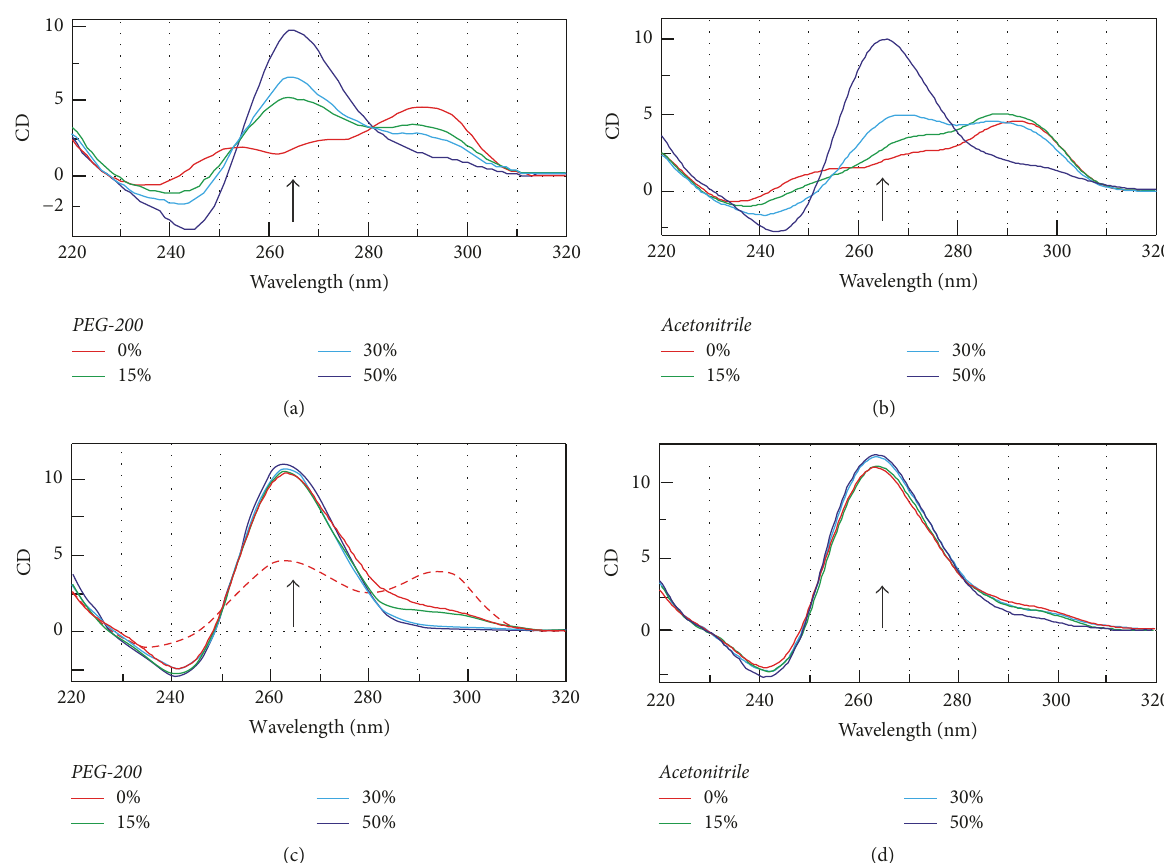
Figure 3: CD spectra of HTR (a and b) and THR (c and d) oligomers in a 25 mM mBR buffer (pH 7.0) in the presence of 50 mM KCl (red lines). The samples contain either PEG 200 or acetonitrile; 15% (v/w) (green lines), 30% (v/w) (light blue lines), and 50% (v/w) (dark blue lines). The increase in the magnitude of CD signals at 265 with increasing concentrations of dehydrating agent is marked by an arrow in both panels. Each DNA sample was annealed at 95 ∘ C for 5 min and then allowed to cool overnight at 4 ∘ C. The dashed red line represents the spectrum of THR without annealing.